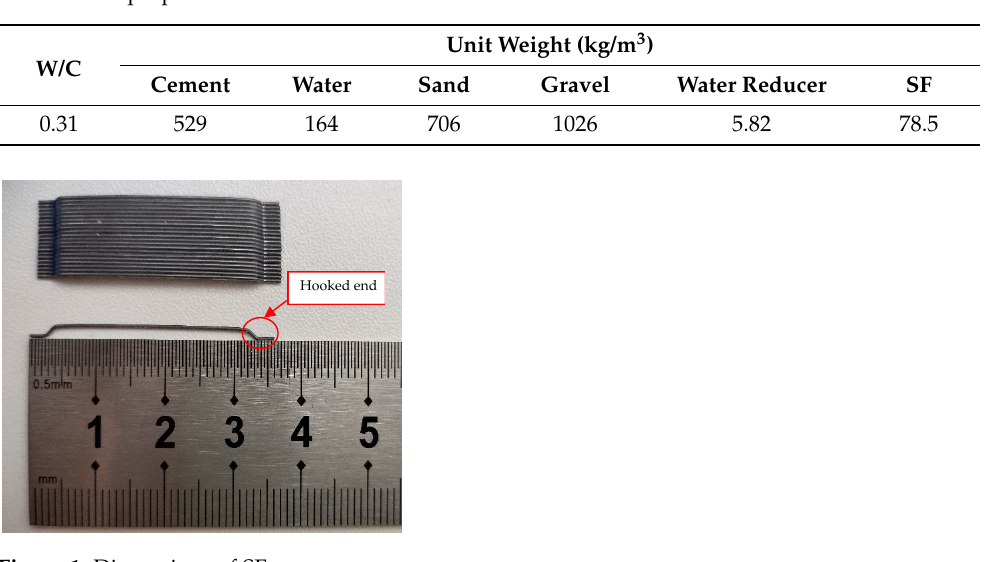
Figure 1. Dimensions of SF.